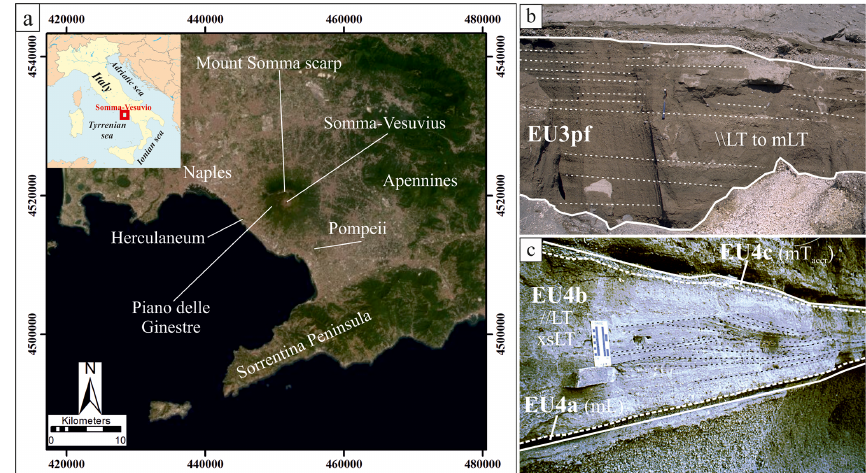
Figure 2. (a) Location of the Somma–Vesuvius volcano. Coordinates are expressed in the UTM WGS84-33N system. (b) The EU3pf unit (Cioni et al., 2020); (c) the EU4 unit (Cioni et al., 2020). In (b) , solid lines are the limits between EUs, dashed lines are the limits between levels ( a , b and c ) and dotted lines are lithofacies stratifications. Lithofacies terminology is derived from Branney and Kokelaar (2002): //LT – “plane-parallel lapilli tuff”; mLT – “massive lapilli tuff”; xsLT – “cross-stratified lapilli tuff”; mL – “massive lapillistone”; and mT accr – “massive tuff with accretionary lapilli”. Service layer credit source: Esri, DigitalGlobe, GeoEye, Earthstar Geographics, CNES/Airbus DS, USDA, USGS, AeroGRID, IGN and the GIS User